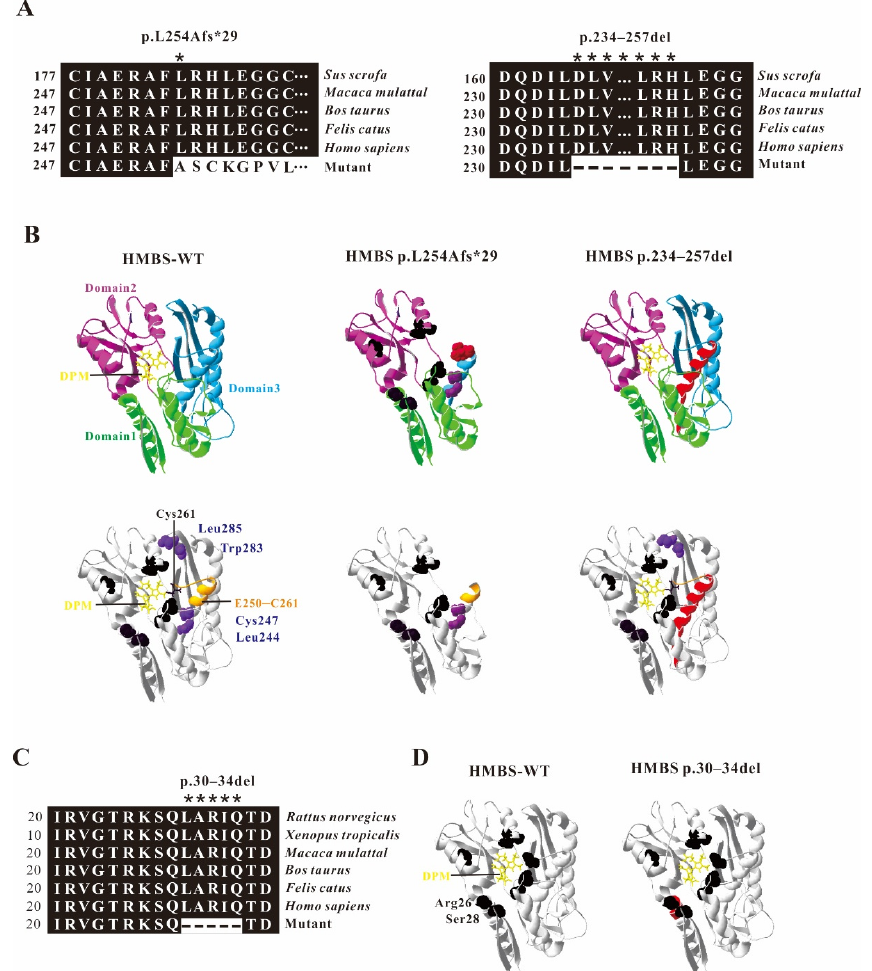
Figure 4. Analysis of HMBS mutations. ( A ) Evolutionary conservation of amino acid residues altered by c.760–771+2delCTGAGGCACCTGGinsGCTGCATCGCTGAA (p.234–257del and p.L254Afs*29) across different species. NCBI accession numbers are Rattus norvegicus : NP_037300.2; Xenopus tropicalis : NP_001005635.1; Macaca mulatta : NP_001253589.1; Bos taurus : NP_001039672.1; Felis catus : NP_001171279.1; Homo sapiens : NP_000181.2. Asterisk (*) means different or missed amino acids. ( B ) Ribbon representation of the HMBS-WT and map of HMBS p.L254Afs*29 and HMBS p.234–257del by homology modeling analysis. HMBS is a monomer enzyme with three domains as pointed out. The active site is shown in black, the mutant or missing amino acids is shown in red; the sliding ring E250–C261 is shown in orange, and the amino acids involved in structural stability are shown in blue. ( C ) Evolutionary conservation of amino acid residues altered by c.88-1G>C (p.30–34) across different species. ( D ) Ribbon representation of the HMBS-WT and map of HMBS p.30–34del by homology modeling analysis. HMBS is a monomer enzyme with three domains as pointed out. The active site is shown in black, the missing amino acids is shown in